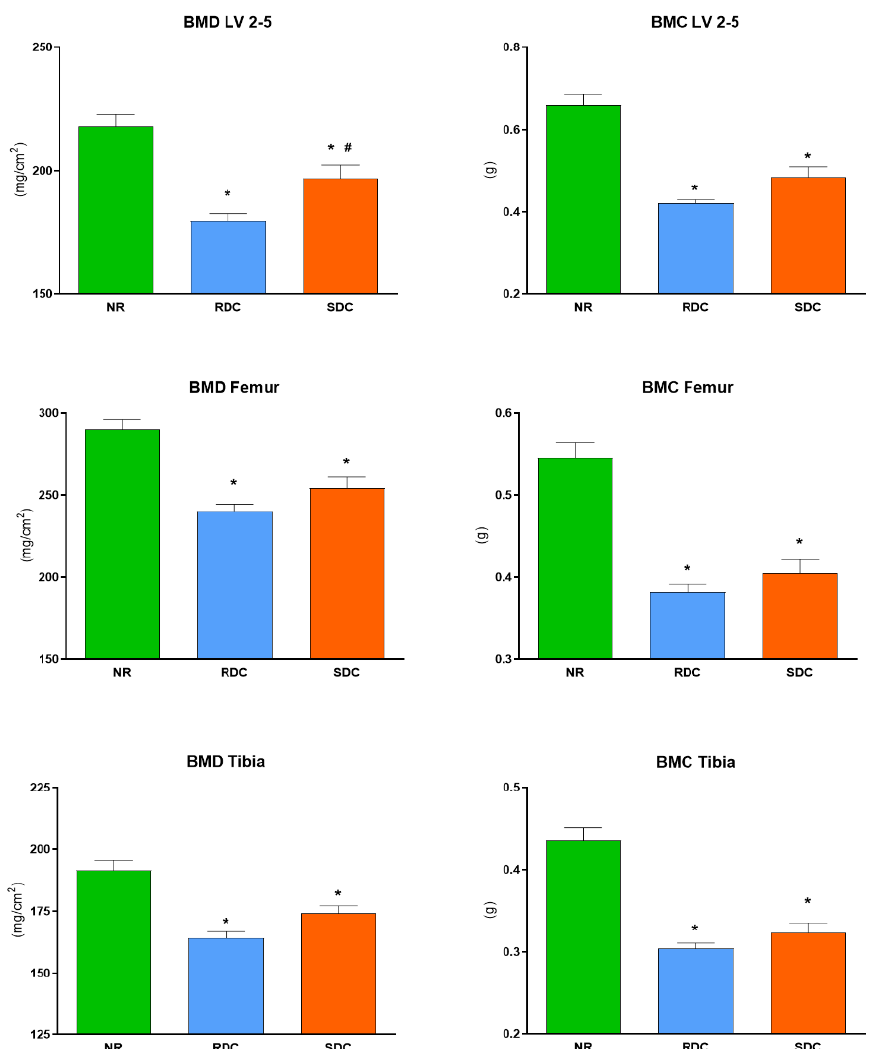
Figure 1. DXA analysis of bone mineral density (BMD) and content (BMC) at the end of the refeeding period. Values are expressed as mean ± S.E.M. NR group, not restricted group; RDC group, refeeding with rapid digestible carbohydrates diet; SDC group, refeeding with slow digestible carbohydrates diet; LV, lumbar vertebrae. * Significant difference compared to NR group ( p -value < 0.05); # significant difference compared to RDC group ( p -value < 0.05).